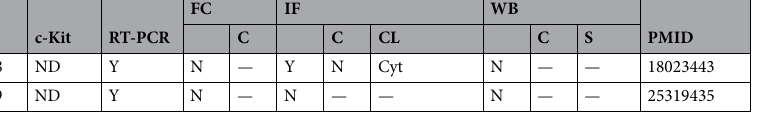
Table 1. List of references reporting a positive expression in hAFSCs. PM: promoter methylation; RT: RT- qPCR; FC: flow cytometry; IF: immunofluorescence; CL: cellular localisation; Nuc: nuclear; Cyt: cytoplasmic; WB: western blotting; C: study includes appropriate controls; S: protein size indicated; N: no; Y: yes; ND: not